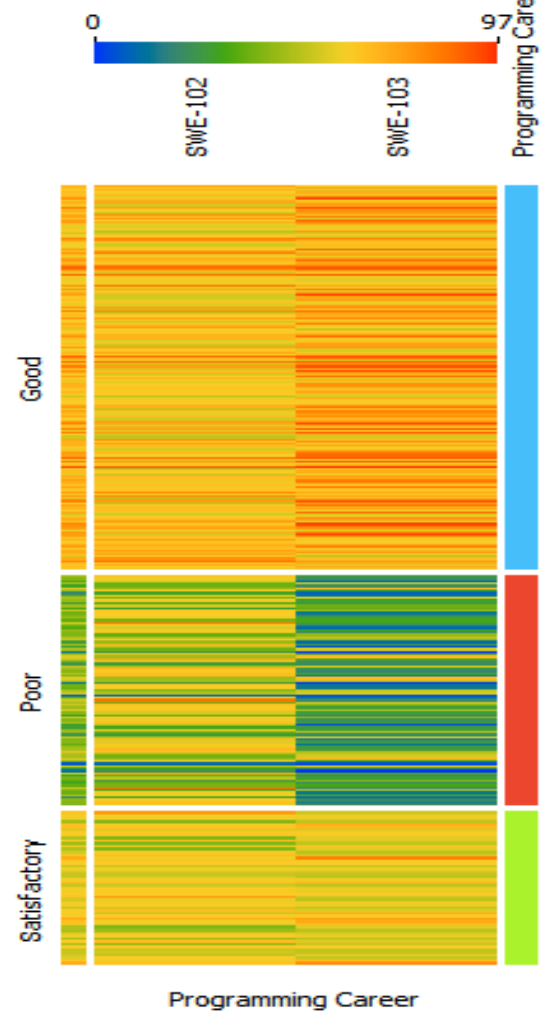
Fig. 4 . Heat map of Cohort